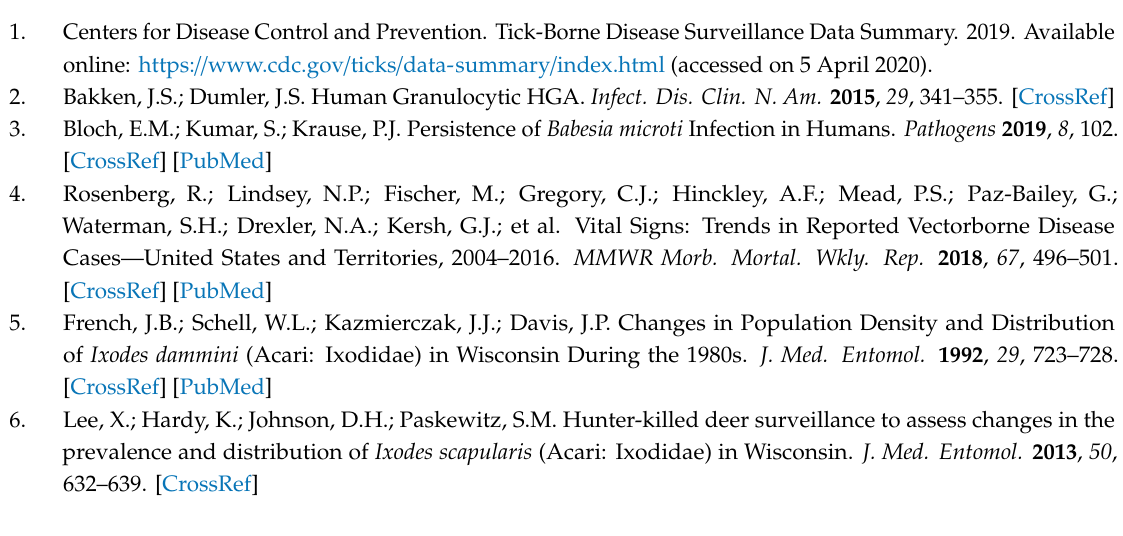
Figure S1: ( A ) MCHS population as a percentage of the Wisconsin 2010 census population for the counties within the MCHS area and ( B ) MCHS population stratified by broad age categories, 2000–2016. Figure S2: Systematic geocoding and case identification workflow applied for MCHS non-Lyme tick-borne disease cases, 2000–2016. Figure S3: Annual mean age of laboratory positive cases for ( A ) HGA, ( B ) babesiosis and ( C ) ehrlichiosis in the MCHS from 2000–2016 stratified on sex. Counts of laboratory positive cases for ( D ) HGA, ( E ) babesiosis and ( F ) ehrlichiosis in the MCHS from 2000–2016 stratified on sex. Figure S4: Primary spatial clusters of HGA within the MCHS for two-year time intervals from 2000–2016. Figure S5: Primary spatial clusters of babesiosis within the MCHS for two-year time intervals from 2000–2016. Figure S6: Relative risk of acquiring a positive laboratory result for a non-Lyme tick-borne disease in the MCHS from 2000–2016, comparing the original 4-year time intervals results to 2-year time intervals for sensitivity analysis. Figure S7: Temporal clusters of laboratory positive cases of HGA using varying time windows (10, 20, 30, 40 & 50%) in the MCHS from 2000–2016. Figure S8: Temporal clusters of laboratory positive cases of babesiosis using varying time windows (10, 20, 30, 40 & 50%) in the MCHS from 2000–2016. Figure S9: Confirmed and probable cases of non-Lyme tick-borne diseases reported to the Wisconsin DHS from